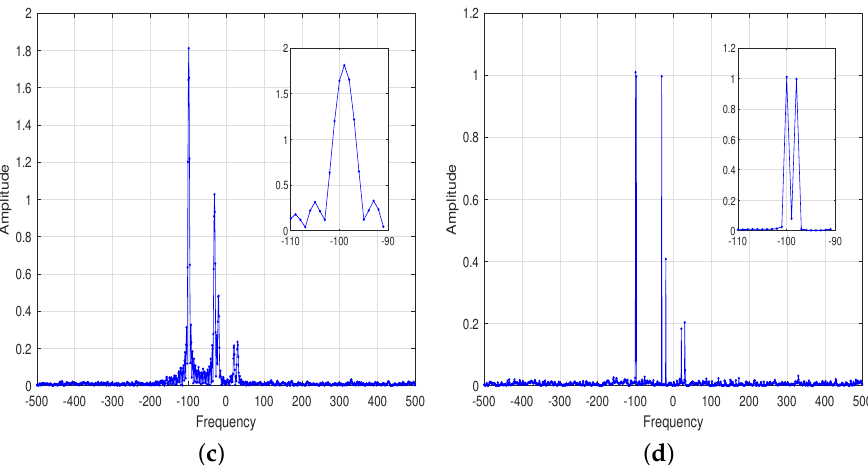
Figure 4. The performance of spectra estimation. ( a ) FFT with long observation time. ( b ) FFT with short observation time. ( c ) zero padding FFT with short observation time. ( d ) IAA with short observation time.